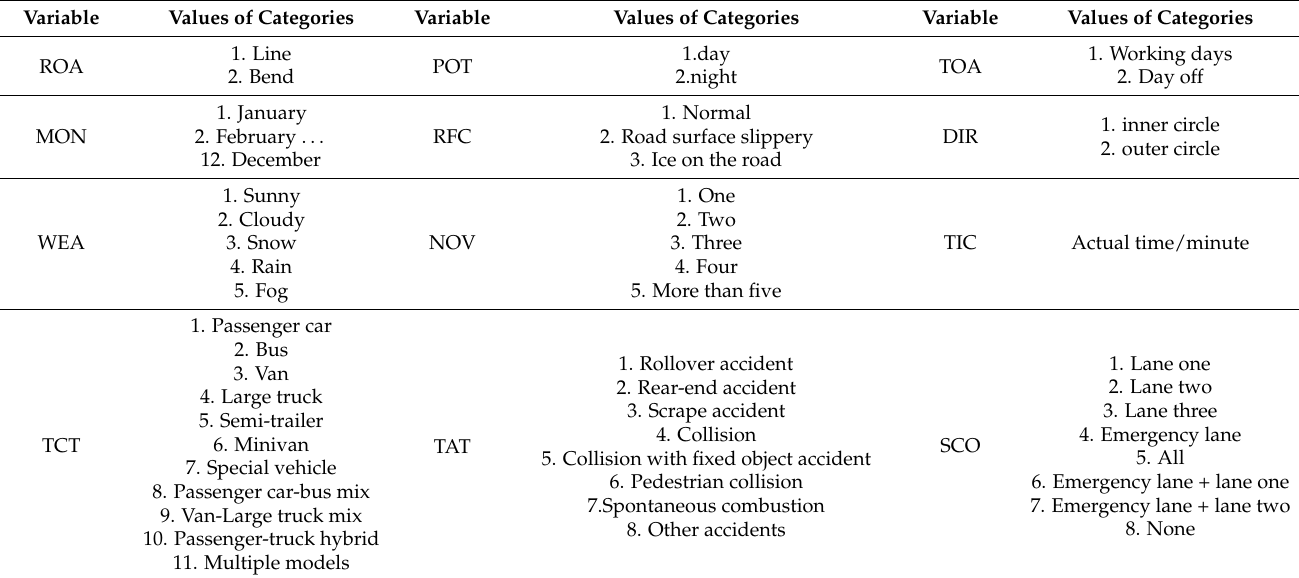
Table 3. List of accident influence